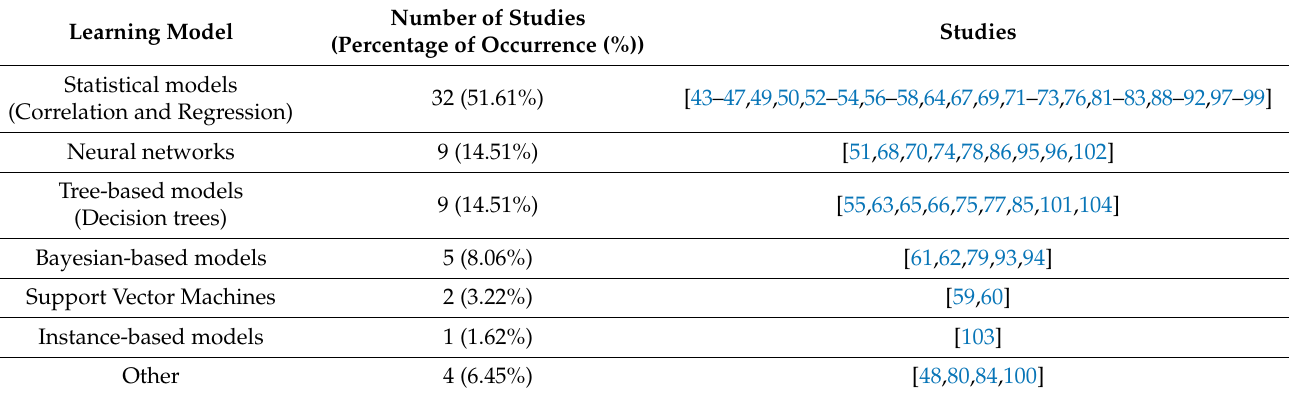
Table 8. Distribution of intelligent predictive algorithms per